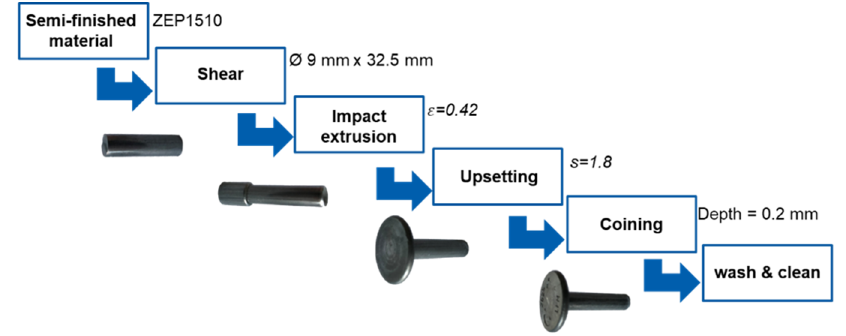
Figure 7. Process sequence sample part from ZEP1510.